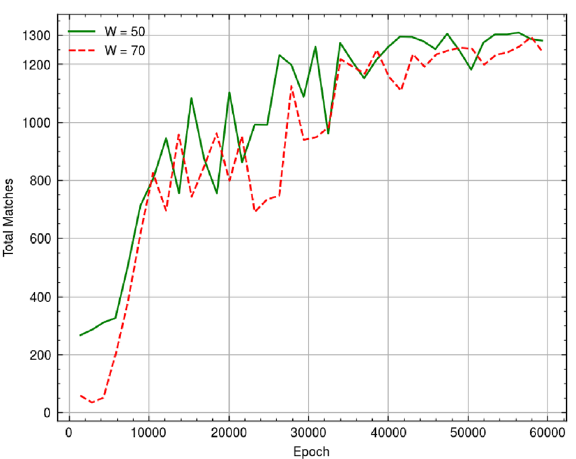
Figure 4. Increasing trend observed for the number of matches obtained by the EdgeAlign RL agent during training for window sizes of 50 and